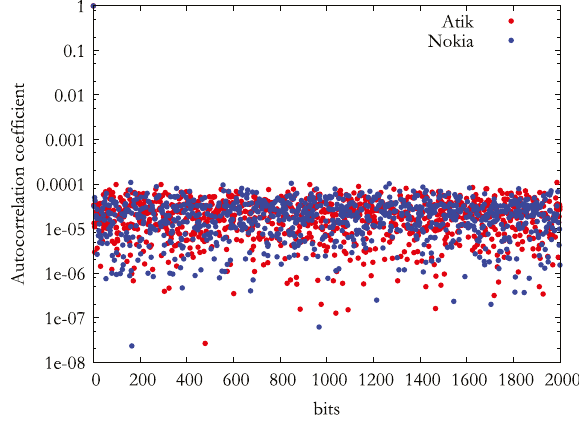
used tests are shown in Fig. 8.